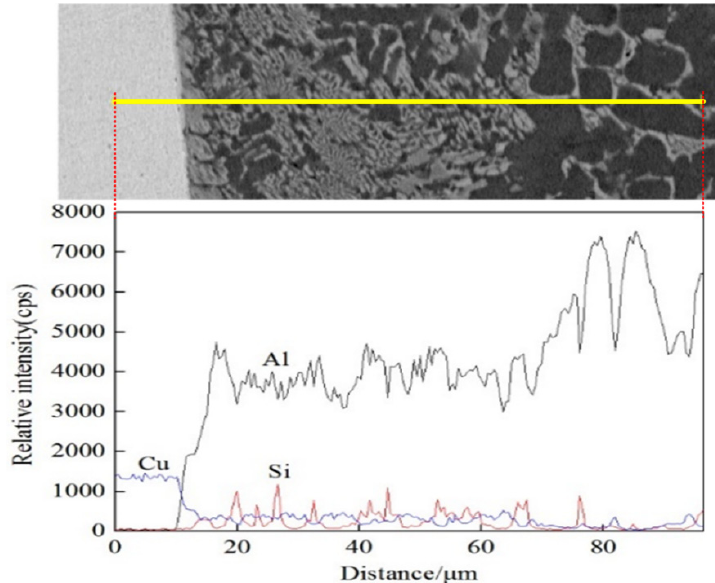
Figure 11. Linear scanning image of the brazing zone of joints at copper side with 4047 filler wires.